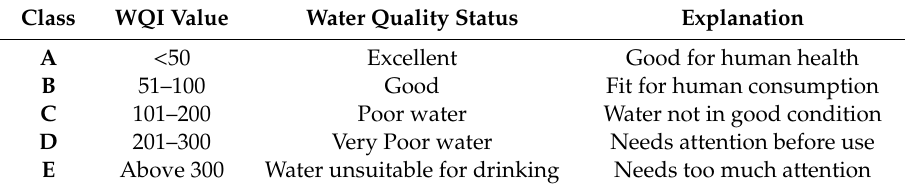
Table 2. Water quality classification based on Drinking Water Quality Index